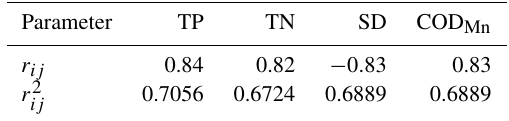
Table 2. The correlation coefficients r ij and r 2 other